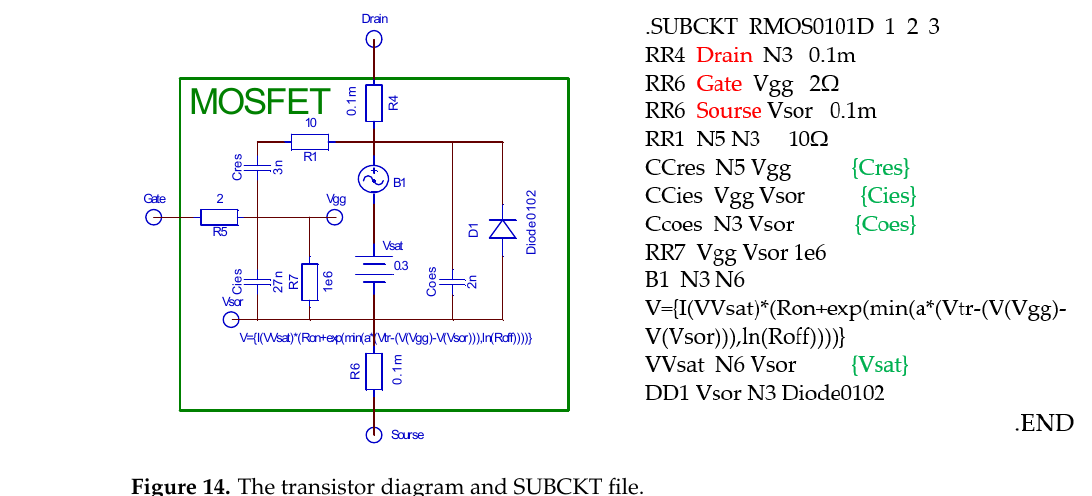
Figure 14. The transistor diagram and SUBCKT file.